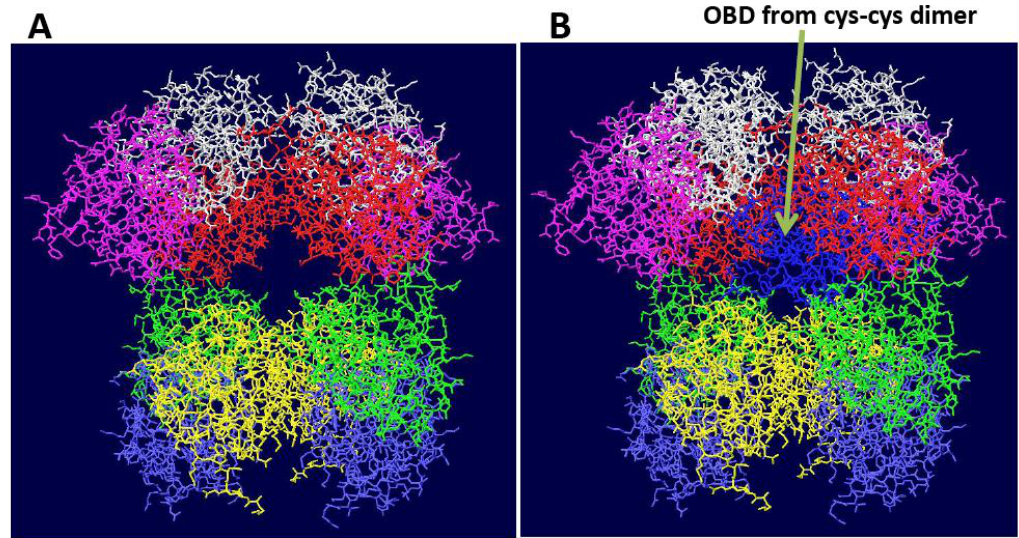
Figure S2. Fitting of OBD dimer structures on the DH. The cys-cys dimer OBD structure [9] was fitted onto one of the OBD monomers of the OBD DH shown in Figure 1A. (A) Starting structure of OBD DH. B) The white OBD monomer on the left was fitted on to one of the OBD monomers (also in white) of the cys-cys dimer. The other monomer of the dimer (blue) does not match any of the other OBDs. Similar problems were obtained with all of the model OBD double hexamers shown in Figure